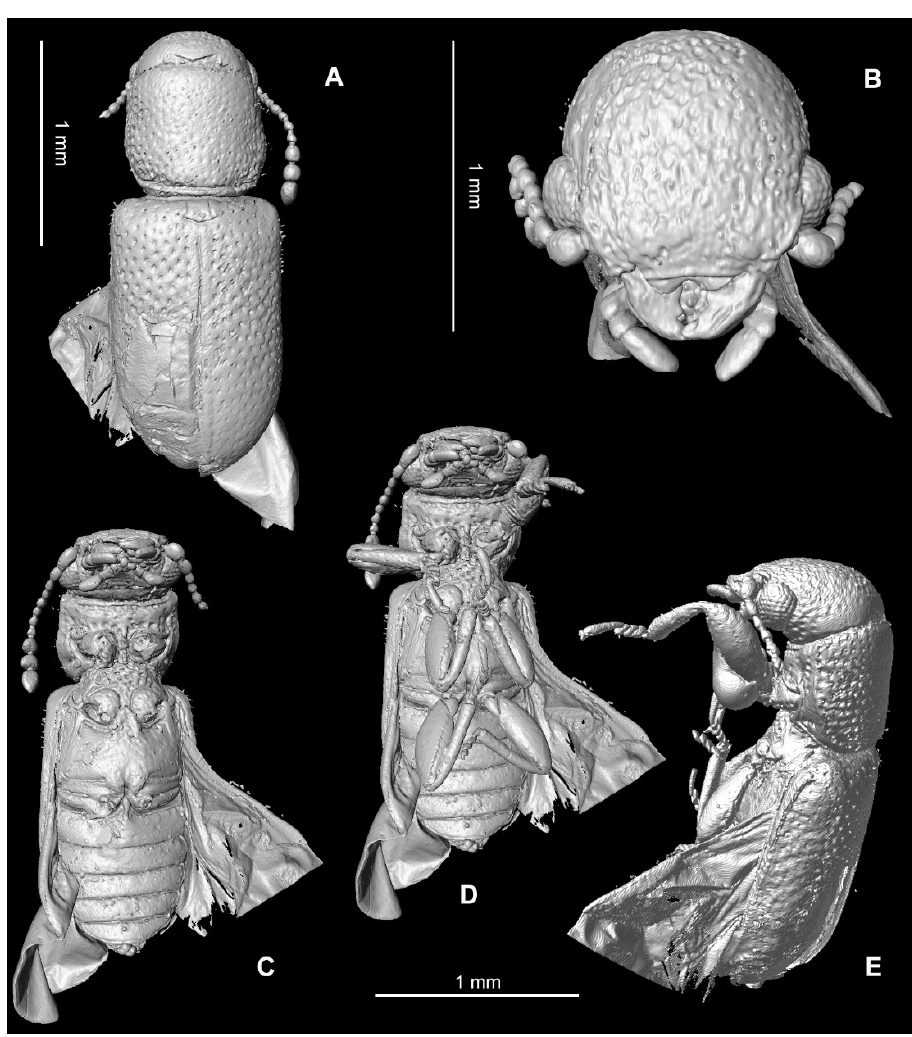
Figure 2. μCT reconstruction of Thanerosus antiquus gen. and sp. nov. holotype NIGP180154: ( A ) body, dorsal view; ( B ) head, anterior view; ( C ) body, ventral view; legs removed; ( D ) body, ventral view including legs; ( E ) body, lateral view.